Question: Reading the figure, is the described quantity rising or falling?
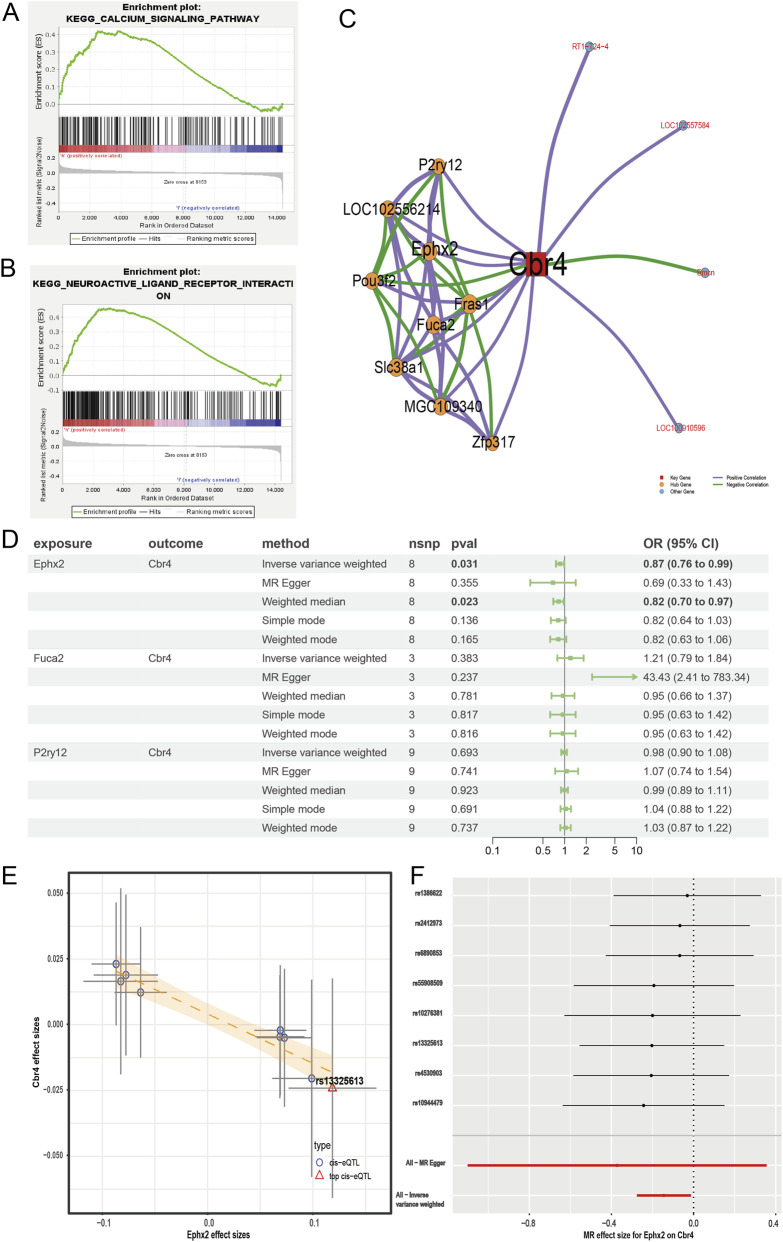
Answer: increasing